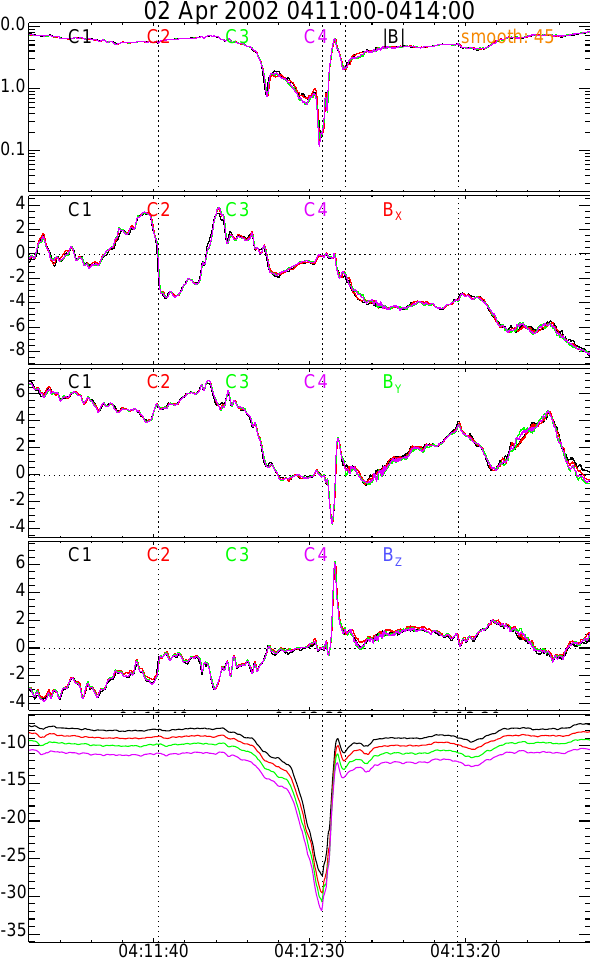
Fig.3. Fig. 3. 2 April 2002 04:11–04:14UT, magnetic fields B and space- craft potentials φ SC ; from top down: FGM magnitude (log scale); FGM GSE components; and φ SC from EFW. Vertical lines denote intervals for hodograms and timing analysis discussed in